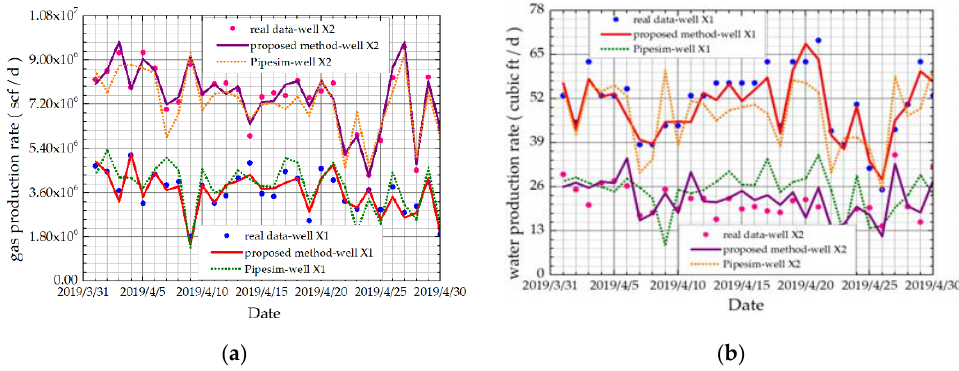
Figure 13. Comparison between the results of the proposed method, the results from PIPESIM, and the real field data: ( a ) comparison of the gas production data; and ( b ) comparison of the water production data.